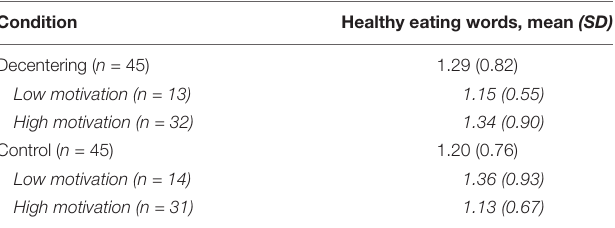
TABLE 4 | Number of healthy eating related words generated by participants with high and low motivation for healthy eating. Condition Healthy eating words, mean